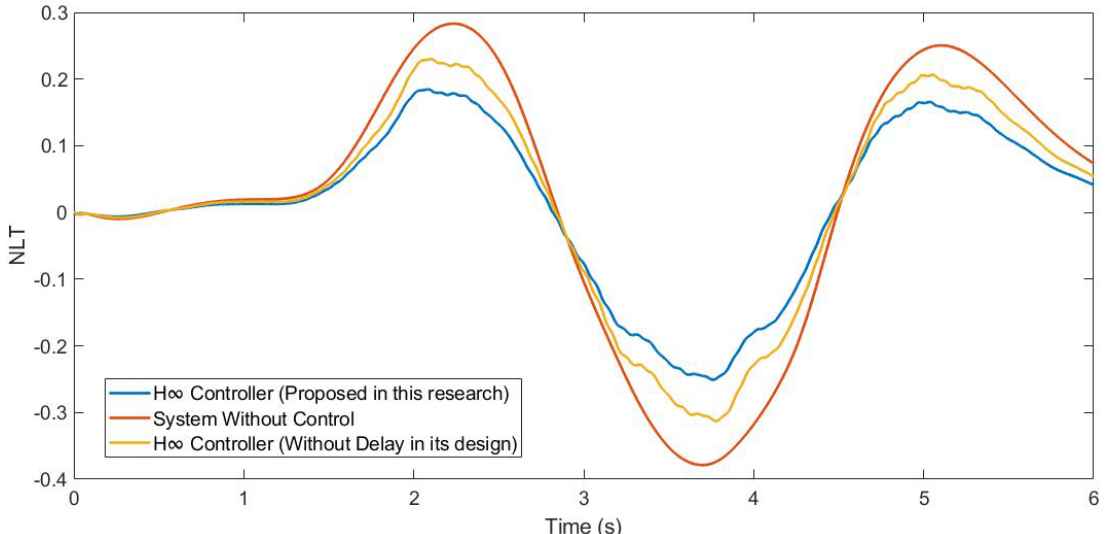
Figure 18. NLT of rear axle for test 2: Double lane change at 100